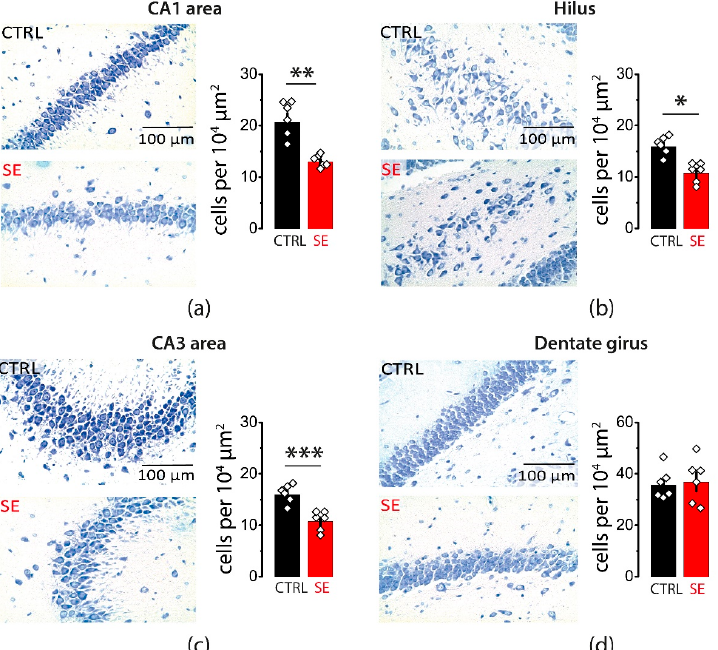
Figure 1. Neurodegeneration in the hippocampal areas 30 days after PTZ-induced seizures. Nissl staining showing neurodegeneration in the str. pyramidale of CA1 ( a ), CA3 ( b ), and hilus ( c ). No significant neurodegeneration was observed in the granular cell layer of the dentate gyrus ( d ). Right: illustrations of stained cells in control (top) and post-SE rats (bottom). Left: the summary data from several animals. The cells were counted along the cell layers and normalized to the length of the layers. The circles show values in individual rats. The bars with error bars are means ± standard errors of the means (SEMs). t -test * p < 0.05, ** p < 0.01 *** p < 0.001.